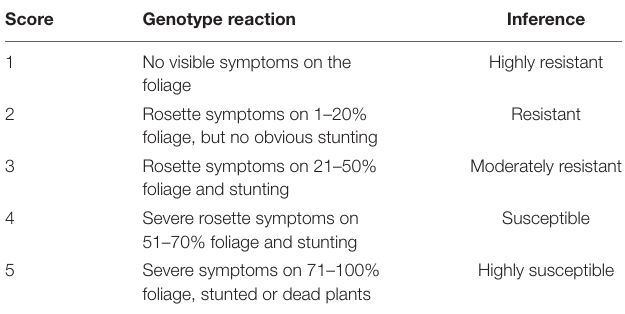
TABLE 2 | The 9 point scale used for screening groundnut for resistance for late leaf spot (Subrahmanyam et al., 1995). Score